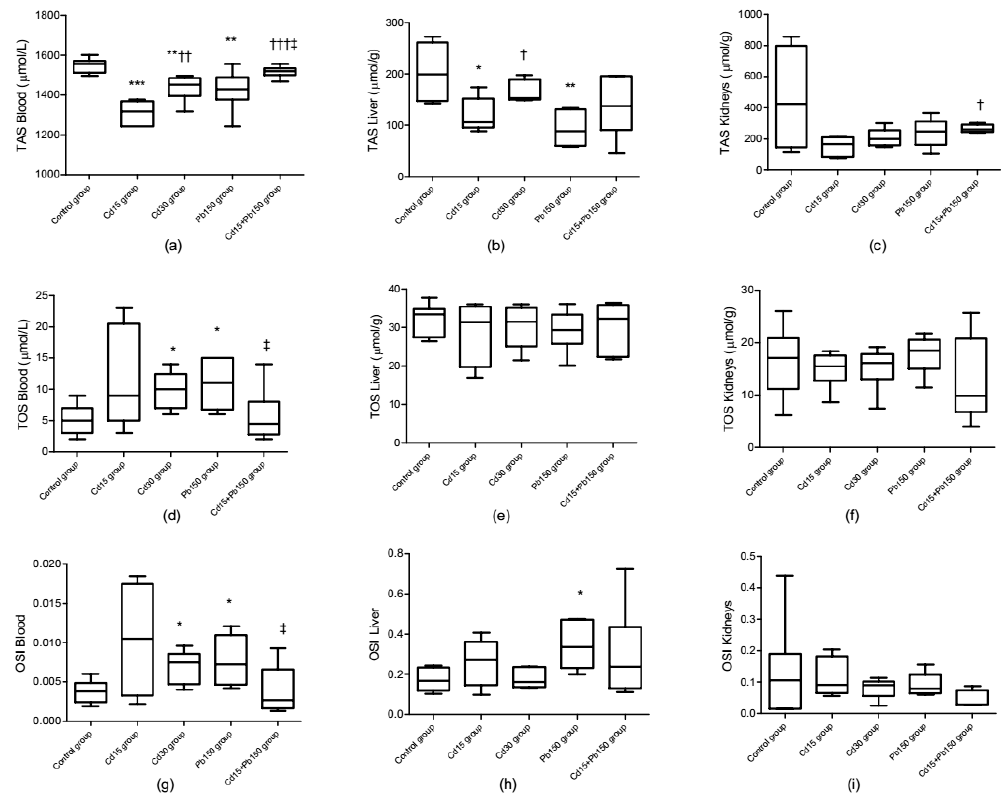
Figure 4. Effect of Cd or/and Pb on total antioxidative status (TAS, panel ( a – c )), total oxidative status (TOS, panel ( d – f )), and oxidative stress index (OSI, panel ( g – i )) values in rat blood, liver, and kidney after acute exposure. Levels of TAS and TOS are expressed on wet tissues. The box represents interquartile range (25–75th percentile), the line within the box represents median value, and ends of the whiskers represent the minimum and maximum values within the group. Statistically significant differences ( p < 0.05) compared to control group are indicated by *, † Cd 15 group, ‡ Pb 150 group. Statistical evaluation was performed using the Kruskal-Wallis nonparametric test followed by Mann-Whitney U test for pairwise comparison. * † ‡ p < 0.05; ** †† ‡‡ p < 0.01; *** ††† ‡‡‡ p < 0.001.